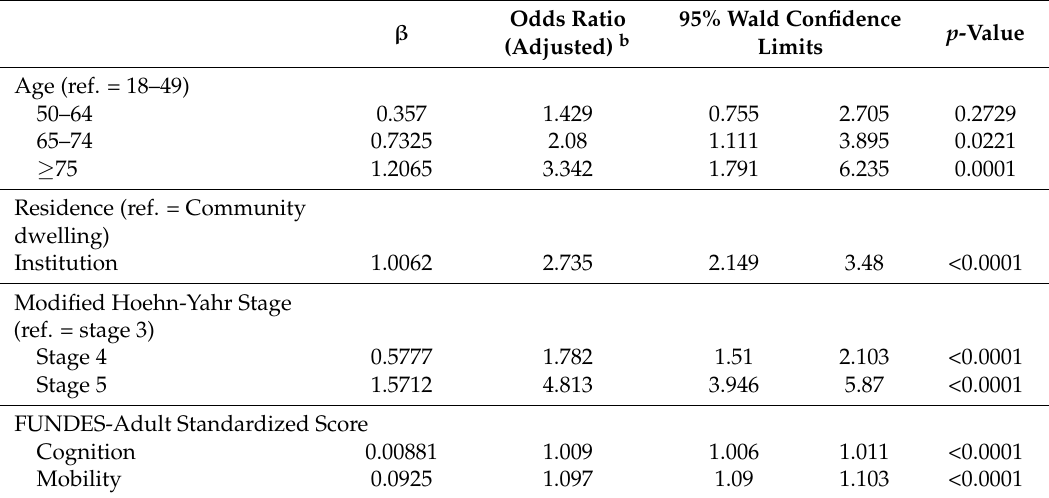
Table 3. Logistic regression, event = not ambulatory, n = 7455 a .